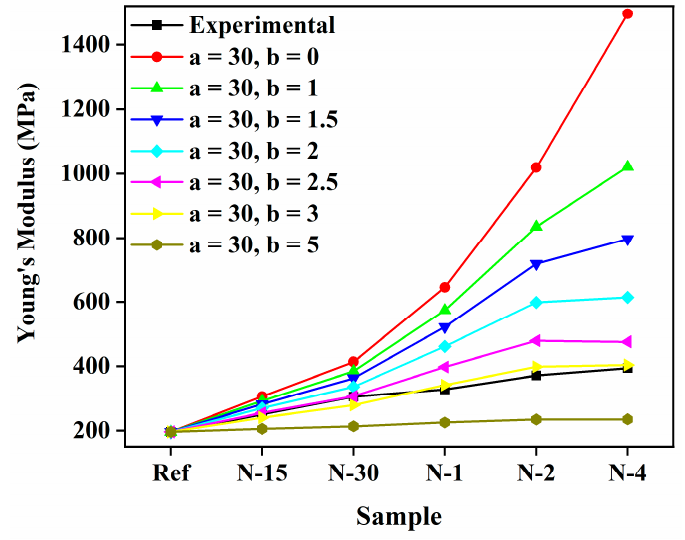
Figure 6. Effect of the aggregation-related coefficient b on E c of the nylon 6 nanofiber-reinforced PUA composites.